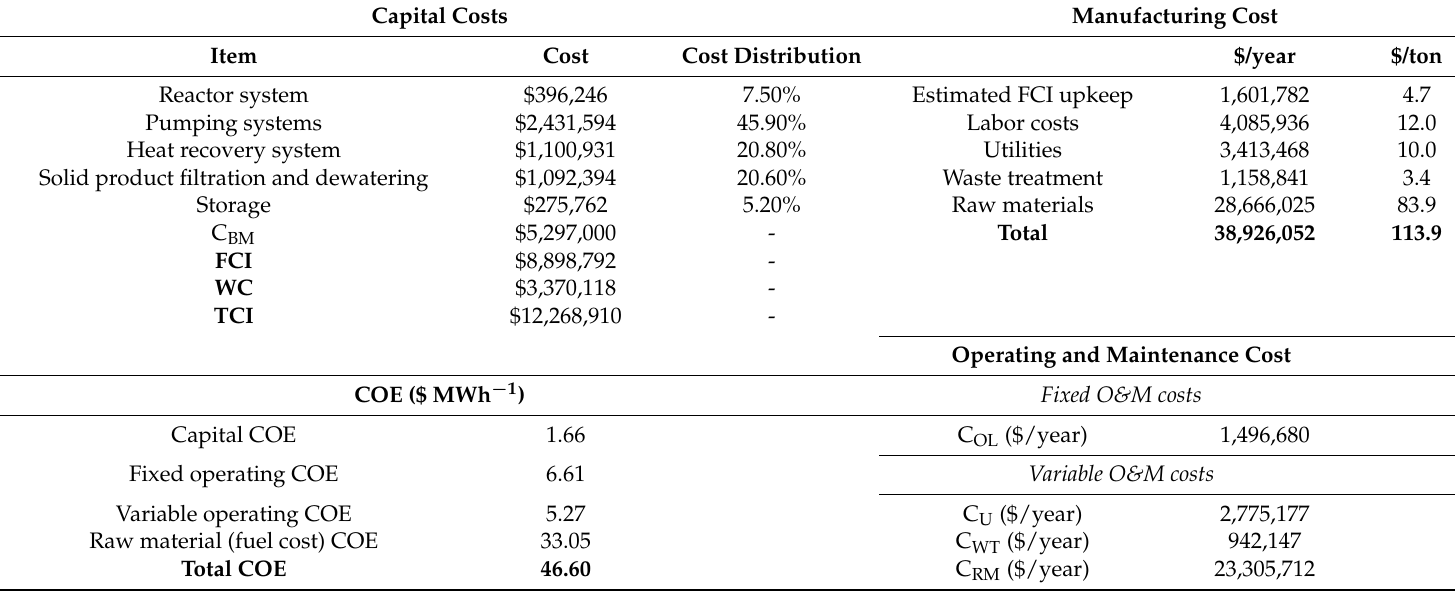
Table 5. Cost summary of Co-HTC plant producing fuel for 110 MWe coal power